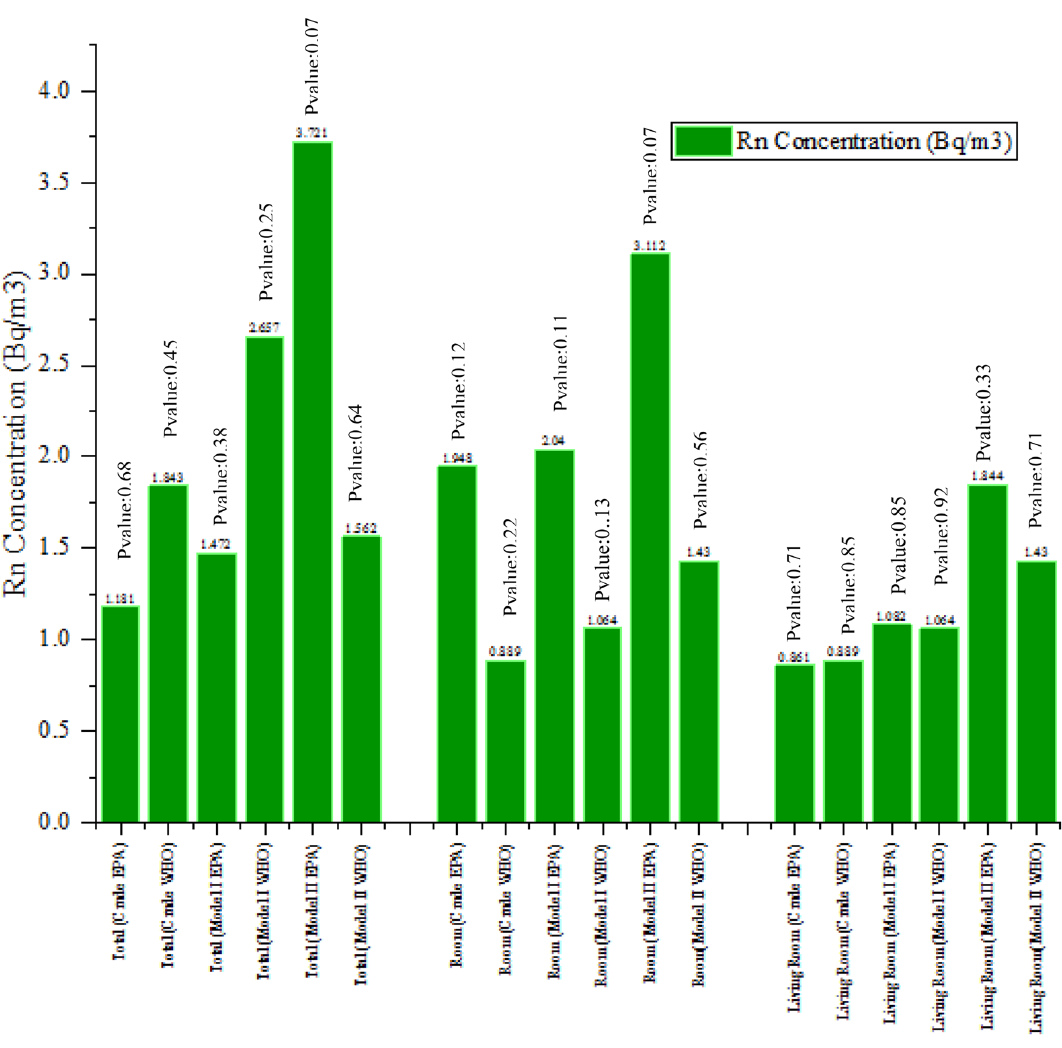
Figure 3. Correlation of Rn gas concentration with